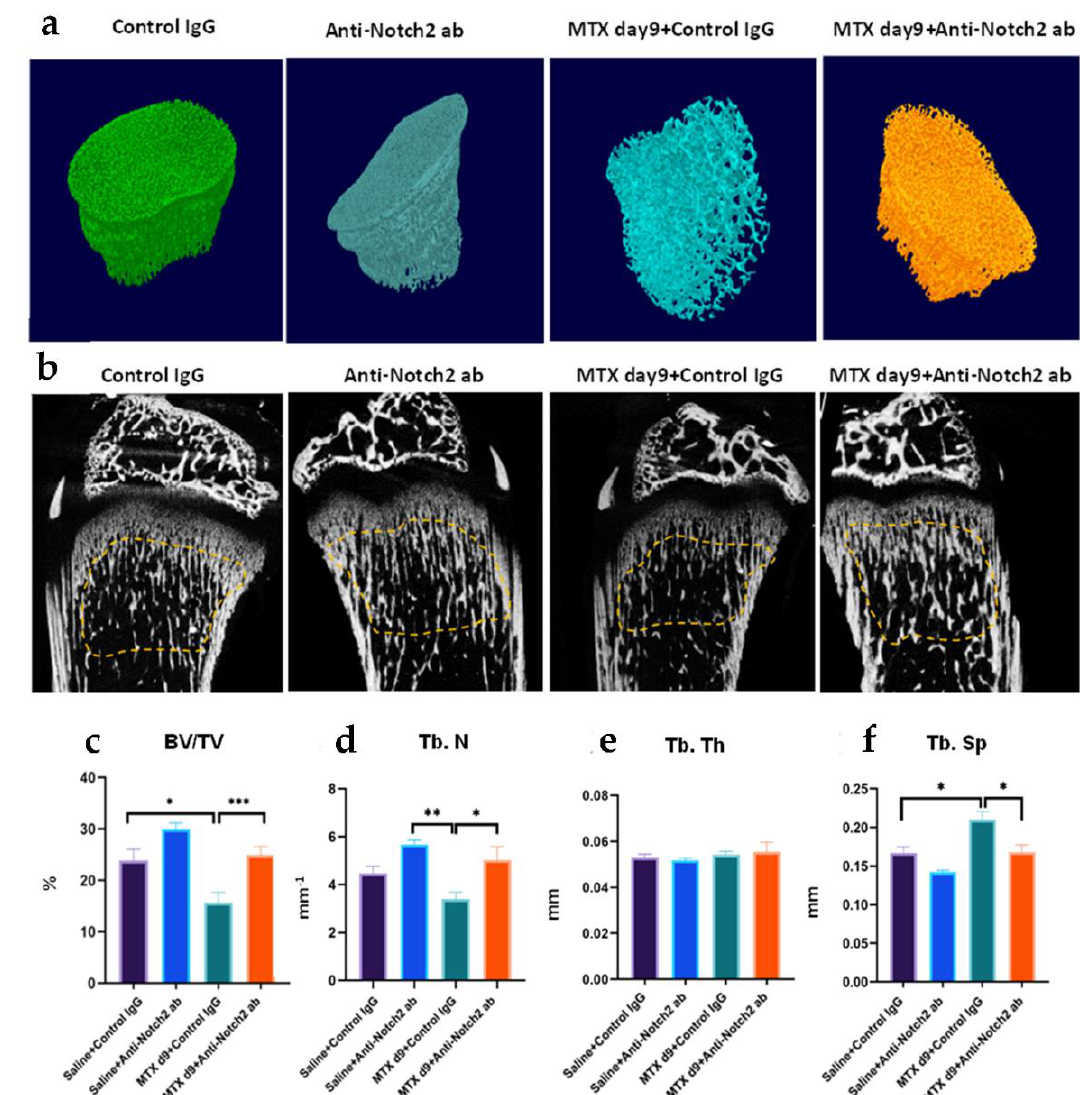
Figure 3. Effect of MTX or MTX + anti-Notch2 treatment on metaphysis volume and micro-architecture at day 9 after the first of 5 daily MTX treatments. ( a ) Micro-CT 3D images showing treatment effects on different groups; ( b ) micro-CT longitudinal cross-sections of tibia, with dotted lines marking the area of bone being analysed; ( c ) treatment effects on bone volume/tissue volume fraction (BV/TV%); treatment effects on ( d ) trabeculae number, ( e ) trabecular thickness, and ( f ) trabecular separation; * p < 0.05, ** p < 0.01, *** p < 0.001.